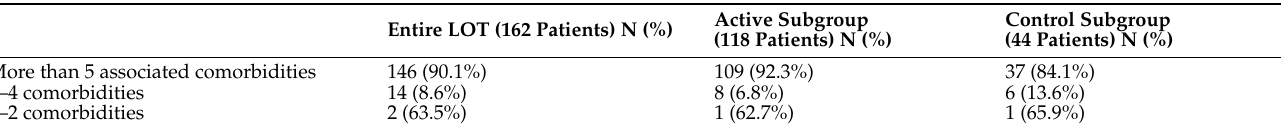
Table 6. The number of comorbidities in the study group and the two research subgroups (the active group of 118 dementia patients and the control group of 44 cognitively normal patients) show a high share of patients having ≥ 5 comorbidities.